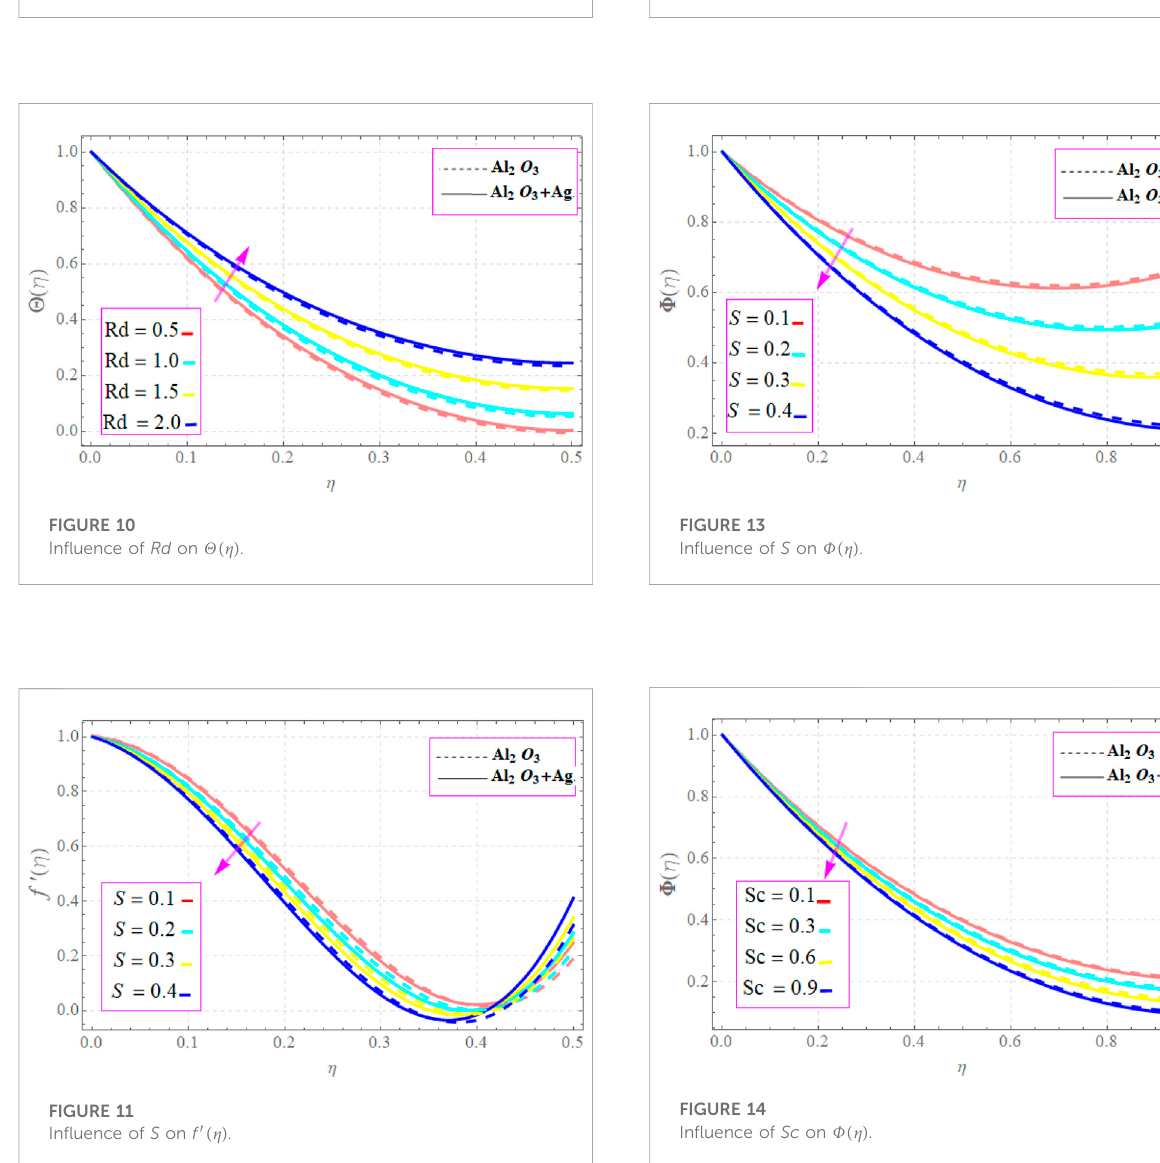
FIGURE 9 In fl uence of Gc on f ′ ( η ) .